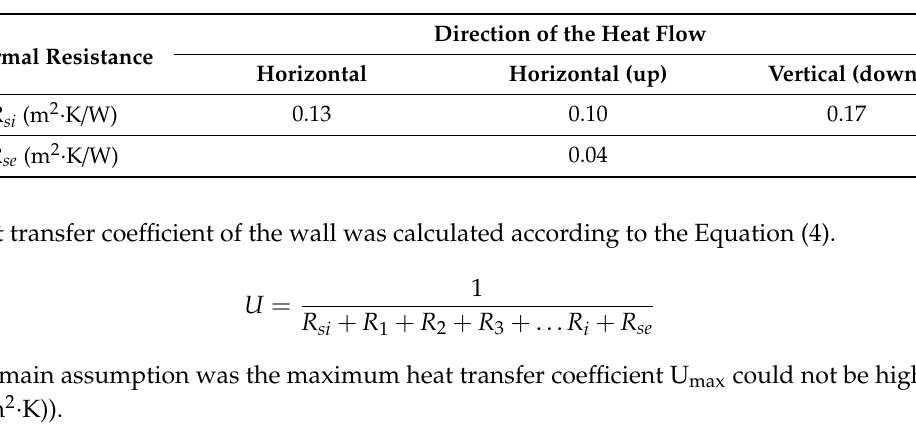
Table 4. Values of the thermal resistance R si , R se